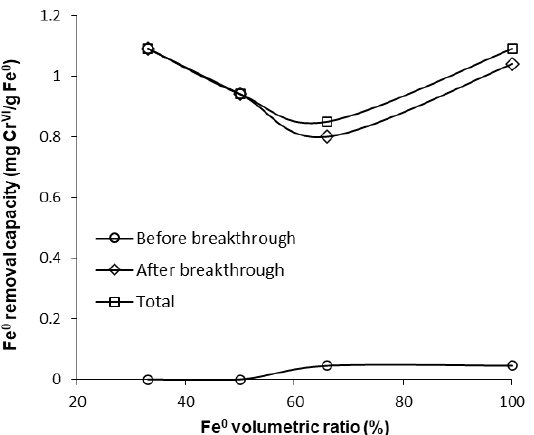
Figure 11. Cr VI removal capacity of Fe 0 at pH 7.1 for columns having fixed Fe 0 volume and variable total reactive zone volume V 2 .